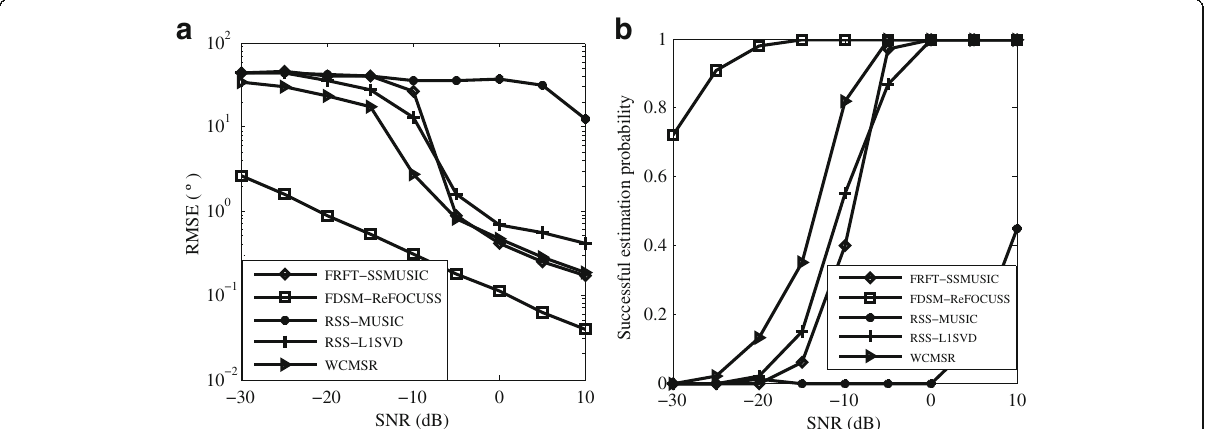
Fig. 5 Estimation performances versus SNR for coherent wideband LFM signals (small angle interval). a Estimation error. b Successful estimation probability